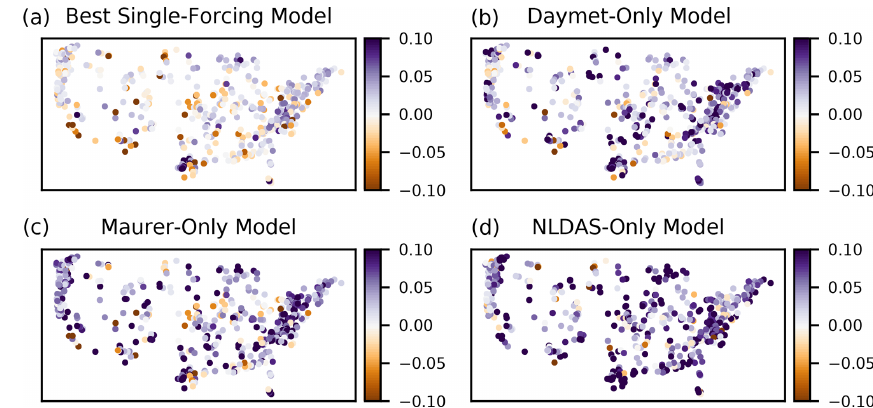
Figure 5. Spatial distribution of the NSE differences between the three-forcing LSTM, relative to the best single-forcing model in each basin (a) and relative to each single-forcing model (b–d) . Positive (purple) values represent basins where the three-forcing LSTM improved over the single-forcing LSTM. Negative (brown) values reflect basins where the single-forcing LSTM had a higher NSE than the three-forcing LSTM. In total, the three-forcing LSTM was better than the best single-forcing model in 351 of 531 basins (66%) and was better than each single-forcing model in 443 (83%; Daymet), 456 (86%; Maurer), and 472 (89%; NLDAS) basins,